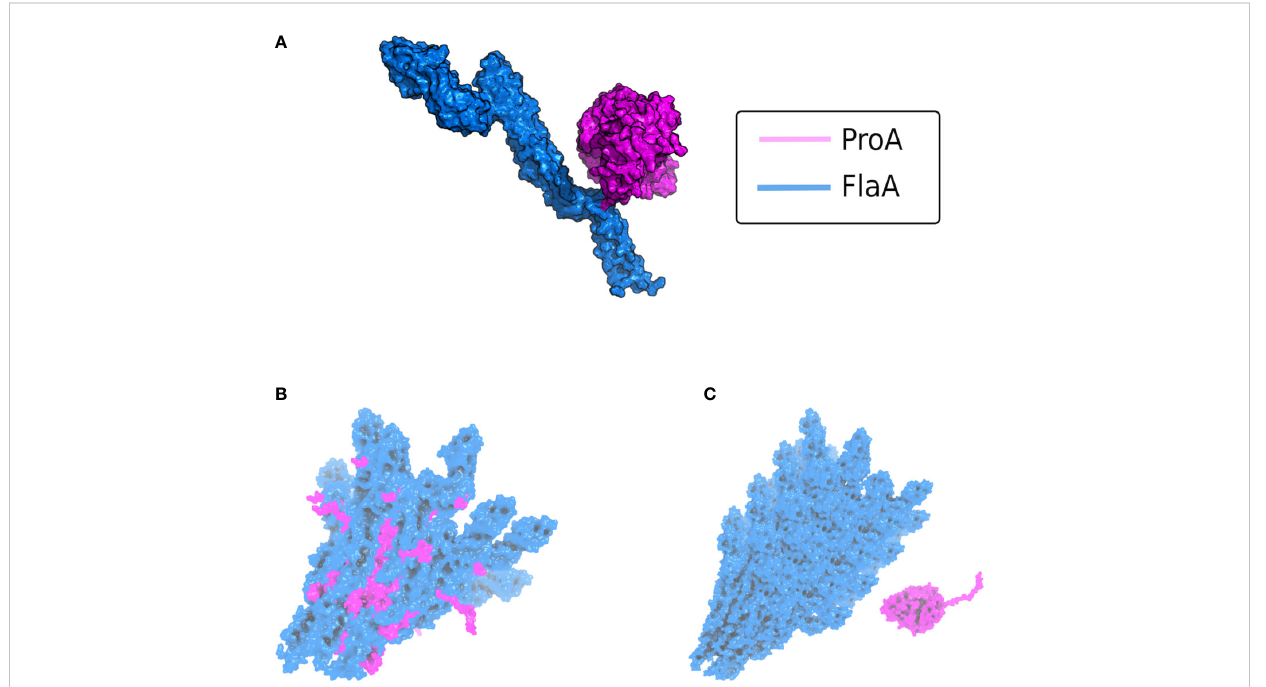
FIGURE 3 AlphaFold v2.2 multimer modeling of the interaction between L. pneumophila ProA and FlaA. (A) Complex of the protease ProA in magenta and monomeric FlaA in marine blue. The binding interface with the most contacts is localized within the D 0 polymerization domain of fl agellin. (B) Modeling of ProA (magenta) and generic polymerized FlaA (marine blue). The fl agellar fi lament was generated by aligning the predicted L. pneumophila FlaA structure on the known Cryo-EM structure of the P. aeruginosa fi lament (PDB ID: 5WK6) (Karagöz et al., 2022). ProA was directly integrated into a deranged fl agellar structure, due to steric clashes in the FlaA polymerization region. These clashes were quanti fi ed using the repulsive Lennard-Jones (LJ) Energy score from the Rosetta scoring modeling suite according to Alford et al., 2017 and corroborated that this is not a possible protein-protein interaction (Alford et al., 2017). (C) Typically assembled fi lament without access for ProA (ProA placed randomly in vicinity). The conserved cleavage sites of FlaA are hidden within the polymerized fl agellar fi